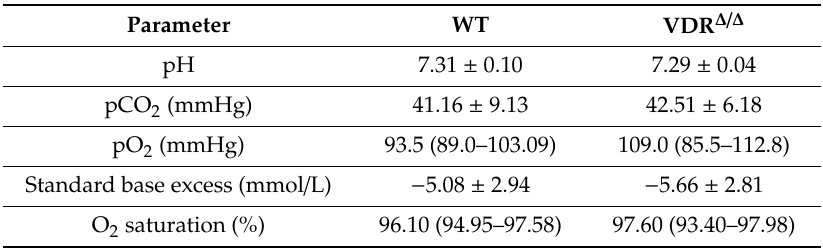
Figure 3. Di ff erences in regional cerebrocortical blood flow (CoBF) induced by carotid artery occlusion (CAO) in VDR ∆ / ∆ vs WT mice in the acute (0–30 s after CAO) and the subacute (30–300 s after CAO) phases of adaptation. The CoBF reductions induced directly by CAO were determined as the area between the curves (ABC) of CoBF reductions ipsilateral and contralateral to CAO. ( A , B ) In the frontal cortex, the ABC did not di ff er between the groups ( n = 8 in both groups, Student’s unpaired t -test). ( C ) The ABC in the parietal cortex was increased in VDR ∆ / ∆ mice as compared to WT animals in the acute phase (* p < 0.05, n = 8, Student’s unpaired t -test) indicating more severe hypoperfusion in the VDR ∆ / ∆ mice, however, ( D ) this di ff erence disappeared in the subacute phase ( n = 8, Mann–Whitney test). ( E , F ) VDR inactivity resulted in increased ABC (i.e., decreased CoBF) in the ipsilateral temporal cortex both in the acute ( E , * p < 0.05, n = 8, Student’s unpaired t -test) and in the subacute phase ( F , * p < 0.05, n = 8, Mann–Whitney test). ( G ) ABC was increased in the zone of pial anastomoses of VDR ∆ / ∆ mice as compared to WT animals in the acute phase (* p < 0.05, n = 8, Student’s unpaired t -test) but ( H ) not in the subacute phase ( n = 8, Student’s unpaired t -test). Normally distributed data are presented as a scatter dot plot with mean ± SD, whereas not normally distributed data are shown as a box and whisker plot with median and interquartile range. Table 2. Arterial blood gas and acid-base